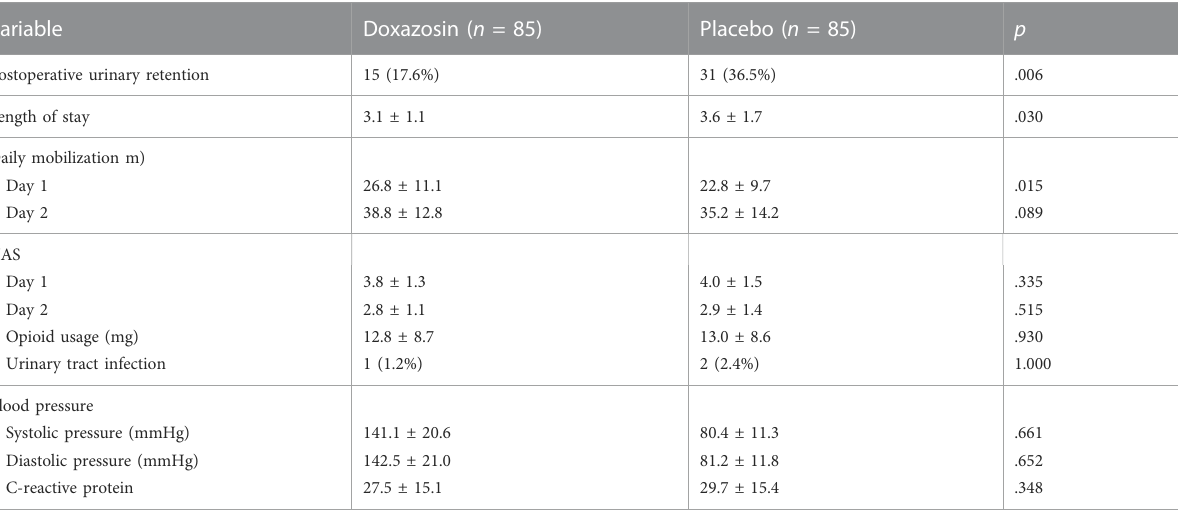
TABLE 2 Outcomes.